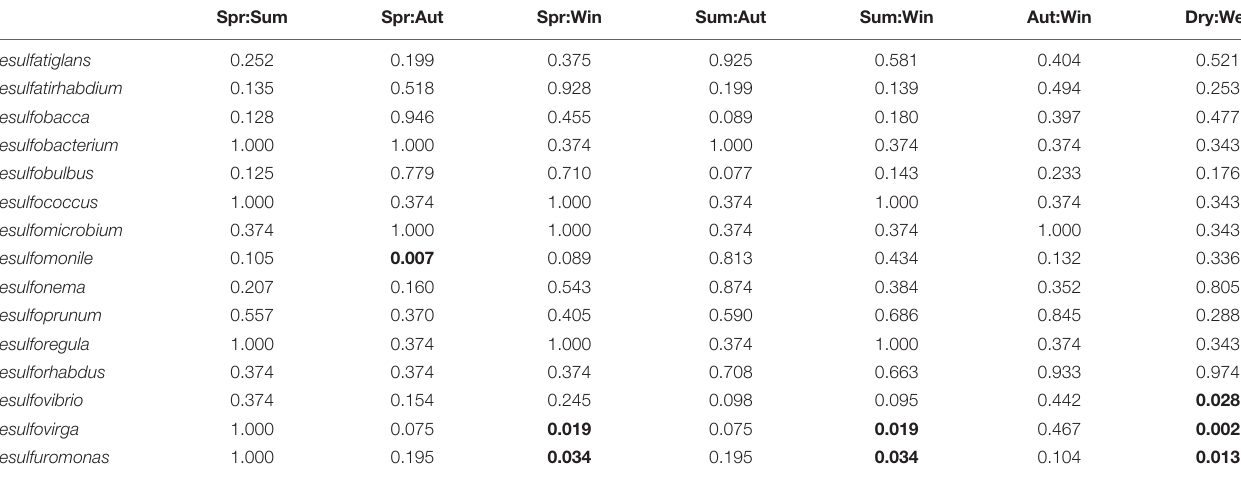
TABLE 6 | Summary of temporal differences in relative abundances of sulfate/sulfur-reducing bacterial genera in microbial communities (Welch’s t -test, P < 0.05). Spr:Sum